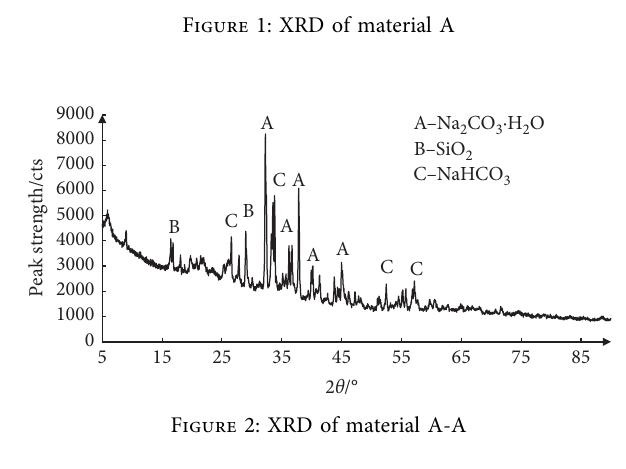
Figure 1: XRD of material A